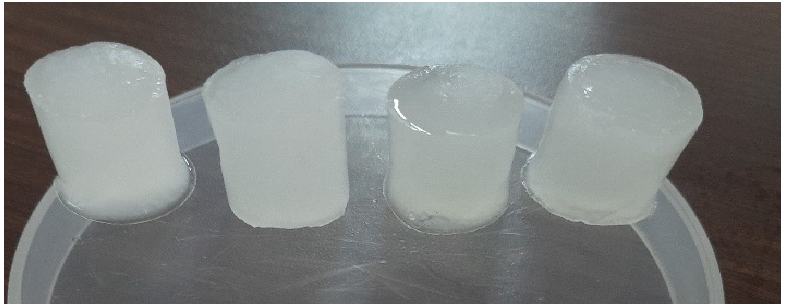
Figure 4 . Macroscopic view of the swollen hydrogel